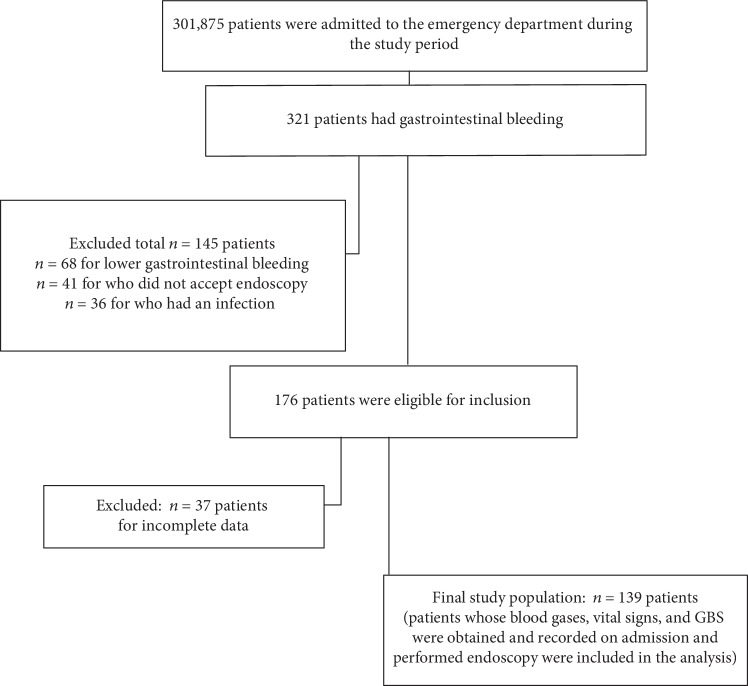
Flow chart of the patients included in the study.